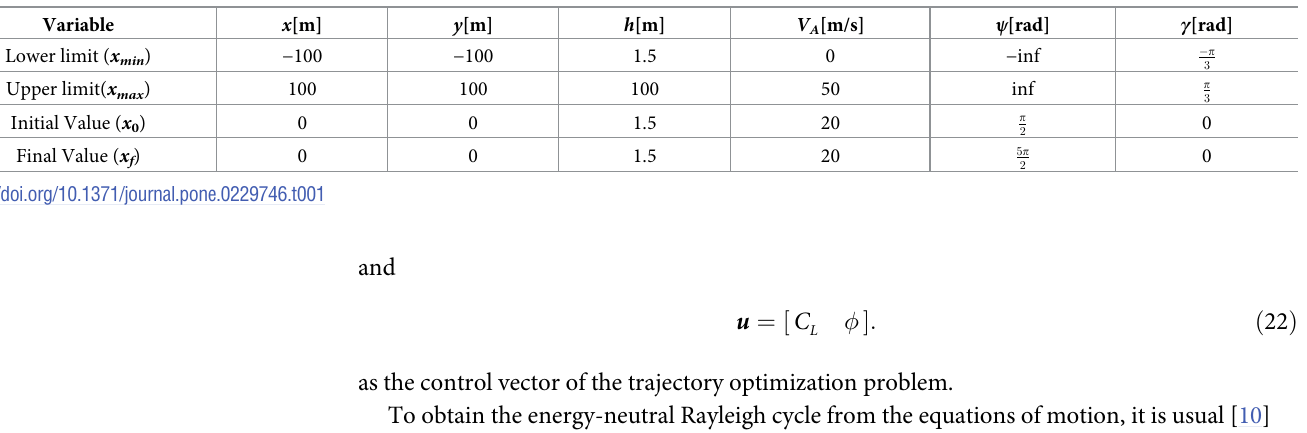
Table 1. Bounds, initial and final values for the state variables. Since the trajectories of interest are closed and energy-neutral, in general, x 0 = x F .